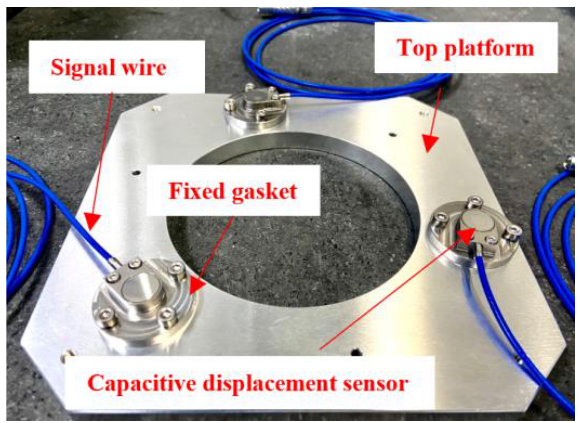
Figure 6. Three capacitive sensors assembled on the top platform.